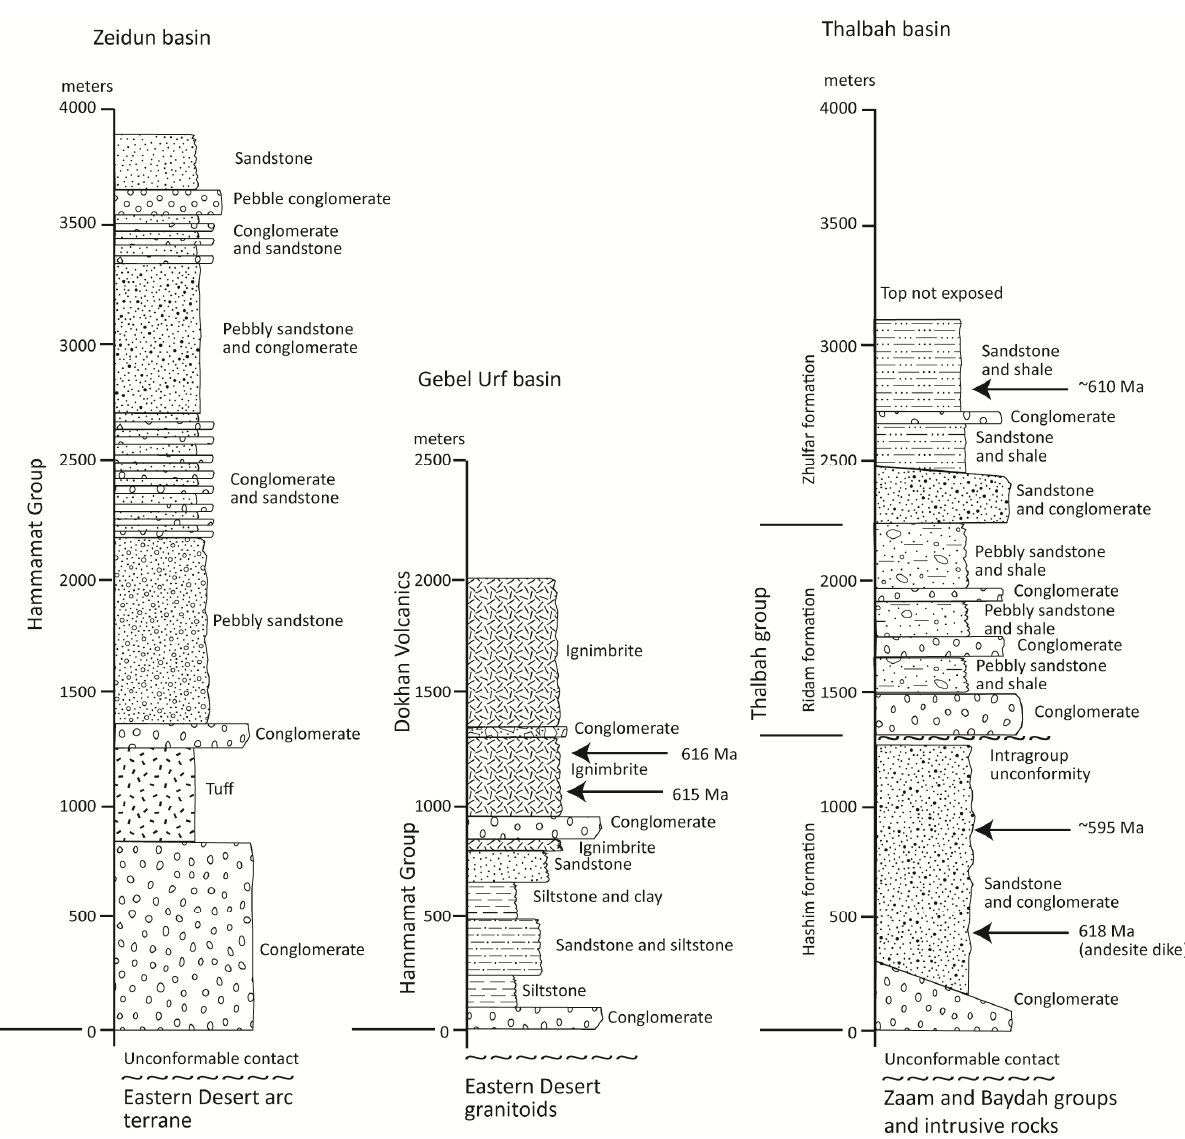
Figure 19. Representative stratigraphic columns for terrestrial Ediacaran successions in the Arabian-Nubian Shield. Zeidun basin after [66]; Gebel Urf succession after [67]; Thalbah group after [68]. See Figures 1 and 18 for locations of these basins. Arrows indicate approximate stratigraphic positions of dated samples discussed in the